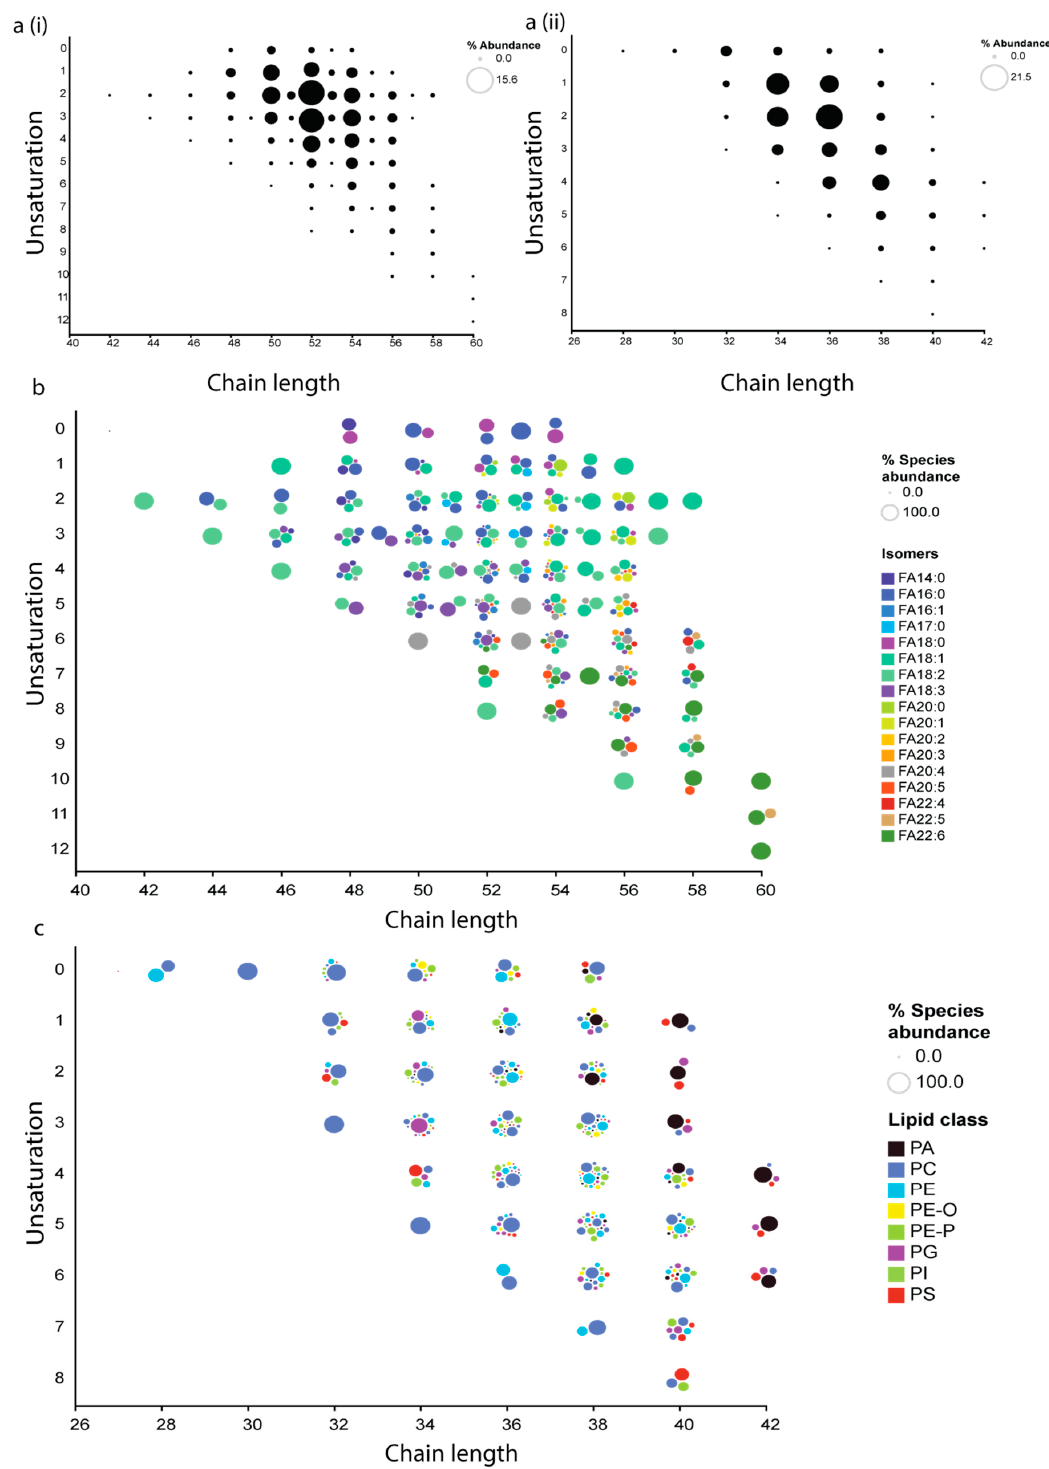
Figure 3. Abundance of different lipids. ( a(i) ) Abundance of different TAGs on the basis of total chain length (as a function of main-chain carbon atoms) and unsaturation. ( a(ii) ) Abundance of different phospholipids on the basis of total chain length and unsaturation. ( b ) A total of 339 TAG isomers were detected from 77 different species of TAG. ( c ) Abundance of 365 phospholipids belonging to 6 classes (PC, PE, PG, PI, PS, and PA), different dots of same color represent isomers. The abundance of the difference lipids/isomers is represented by the varying size of the bubble in all of the